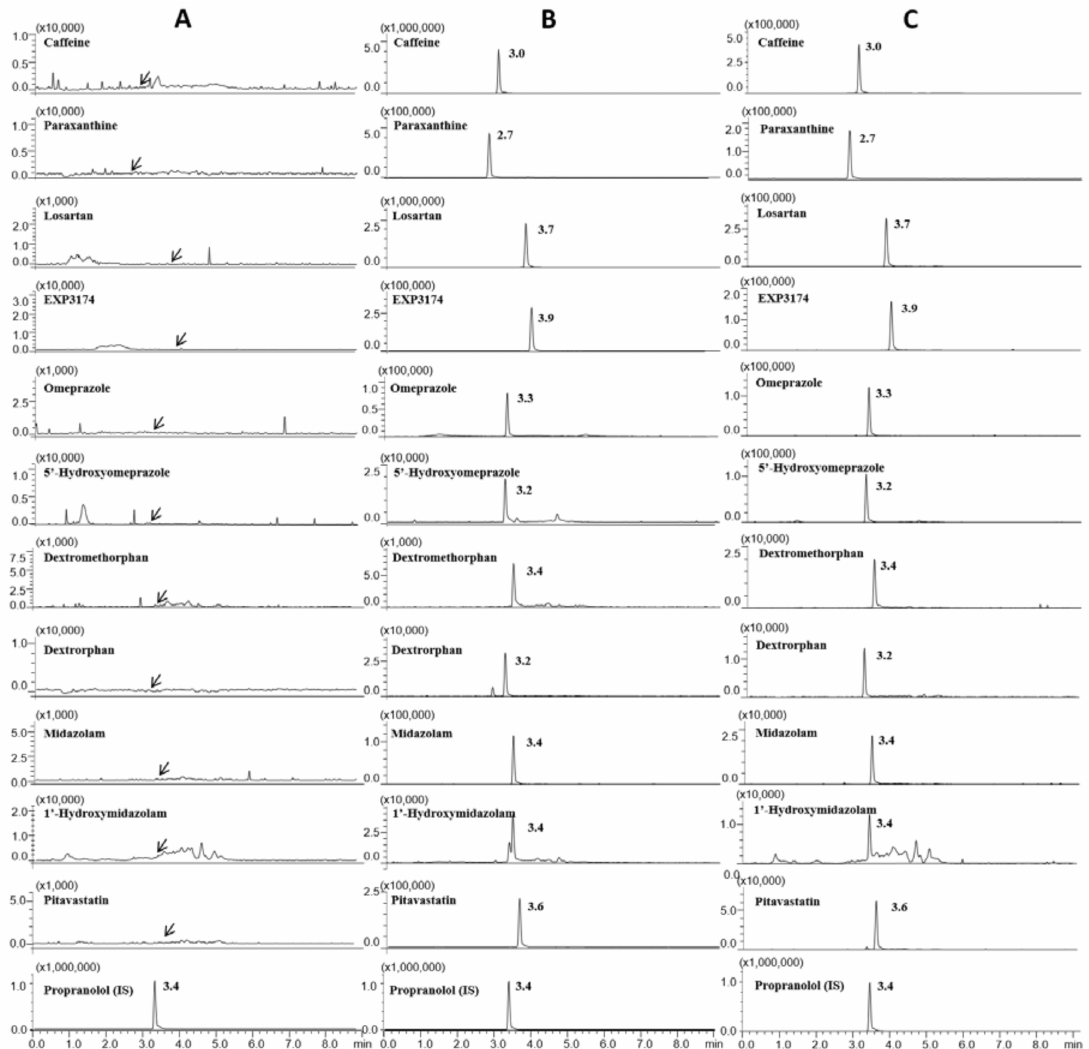
Figure 2. Selected reaction monitoring chromatograms of probe drugs, their metabolites, and internal standard (IS) in ( A ) blank plasma samples spiked with IS, ( B ) plasma samples collected from a subject 1 h after dosing and ( C ) plasma samples spiked with middle quality control (QC)